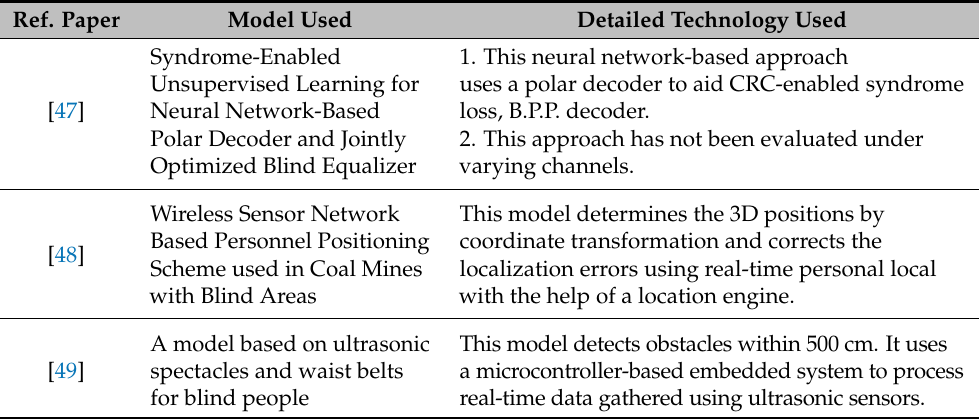
Table 6. Summary of Various Wireless-Network-Based Navigation Tools. Ref.